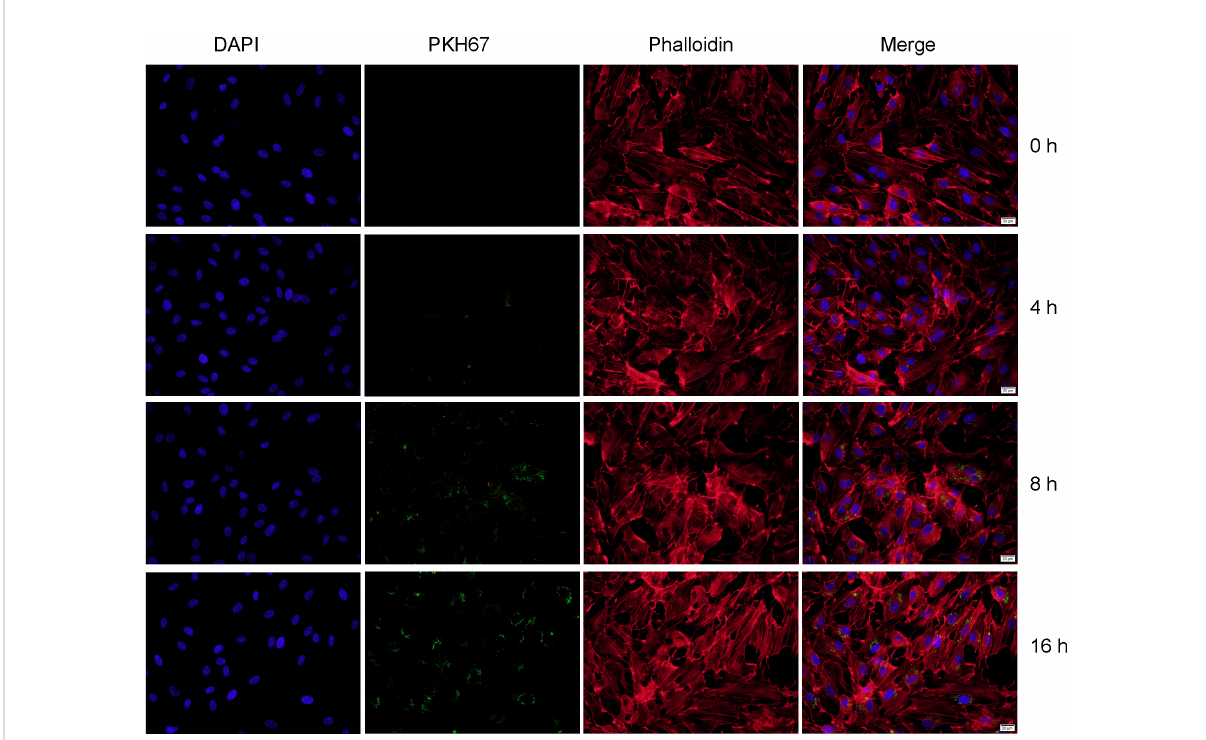
FIGURE 4 Fluorescence staining showed that exosomes from the supernatant of RBE cells could enter HUVECs. Nuclei and cytoskeleton of HUVECs were labeled with DAPI (blue) and phalloidin (red), respectively. Exosomes were labeled with PKH-67 (green). PKH67-labeled exosomes (green) were incubated with HUVECs, and PKH67-labeled exosomes were detected inside the HUVECs as visualized using a fl uorescence microscope, indicating that the exosomes entered into the